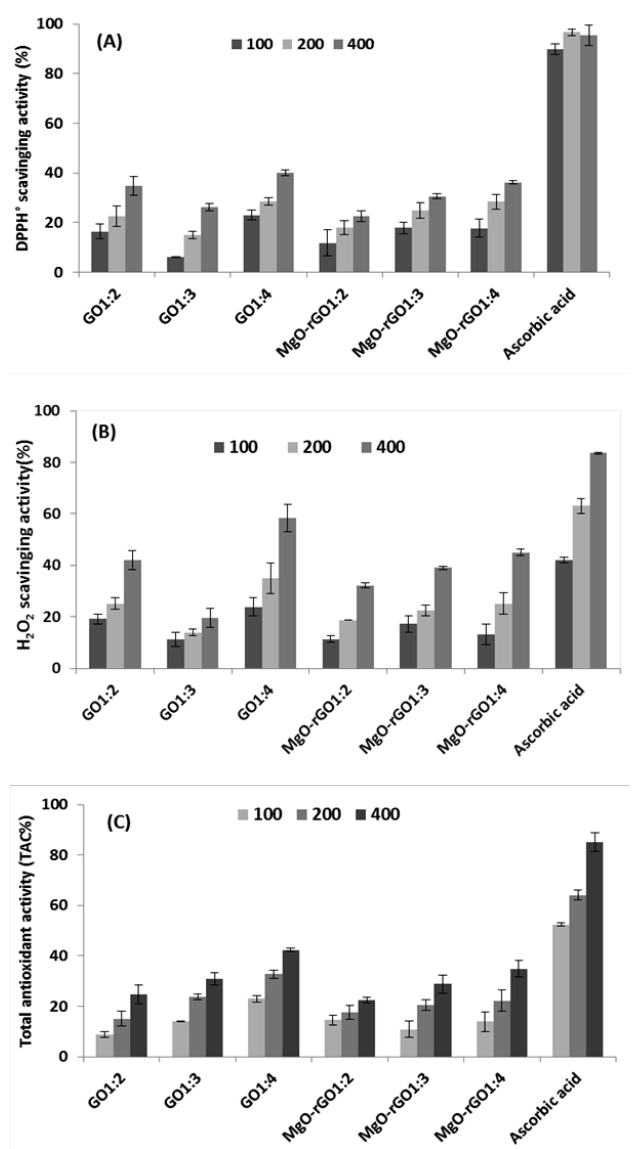
Figure 4. Antioxidant activity of pure graphene oxide (GO), MgO-decorated reduced graphene oxide (rGO) and ascorbic acid at different concentration range (100, 200, and 400 µg/mL) (n = 3): ( A ) DPPH radical scavenging activity; ( B ) H 2 O 2 scavenging activity; ( C ) total antioxidant activity .